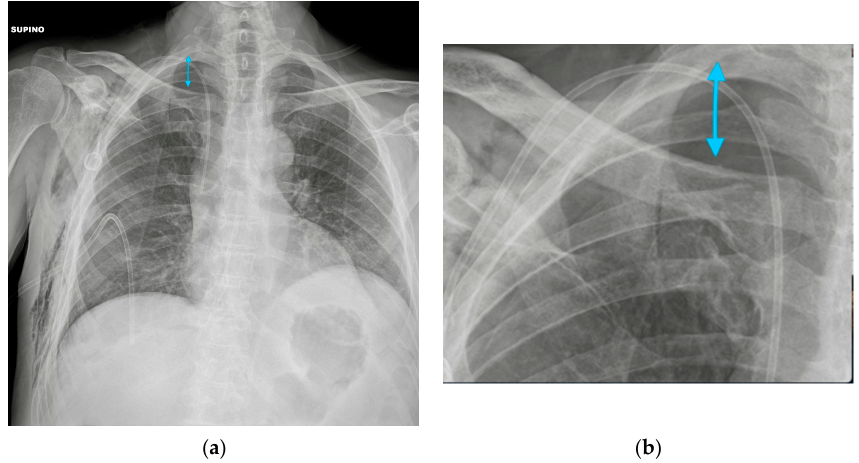
Figure 8. Pneumothorax after PORT positioning. ( a ) A right apical pneumothorax (blue arrow) after the insertion of a right PORT device. A right pleural tube has been placed after the diagnosis. Note the right soft-tissue emphysema. ( b ) A detail of the right apex of the same CXR showing the pleural line.